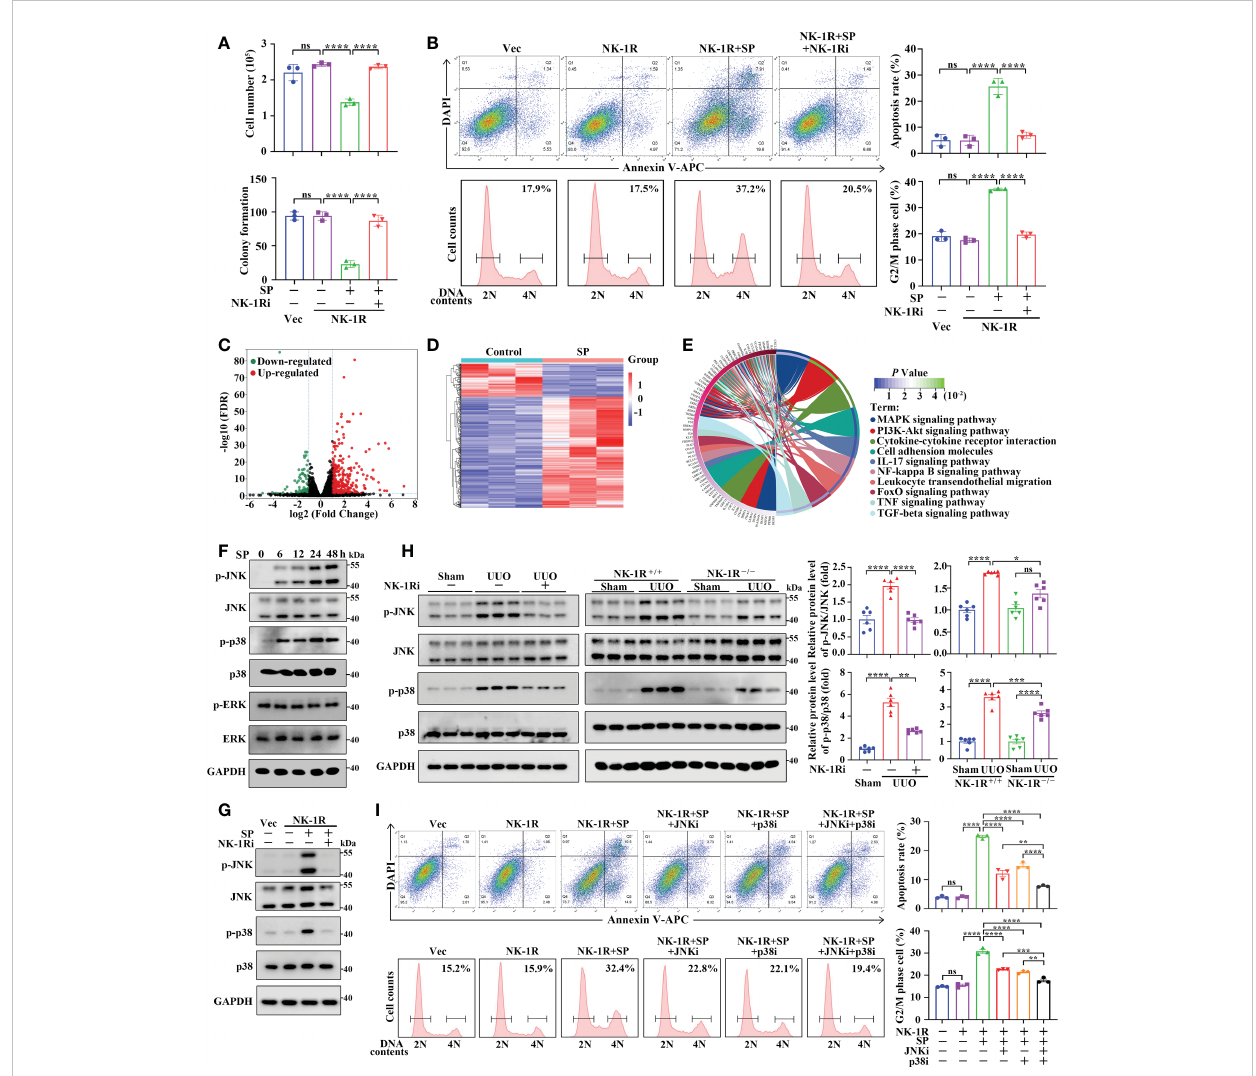
FIGURE 7 SP mediates renal in fl ammation and fi brosis through an NK-1R-dependent JNK/p38 mechanism in vivo and in vitro . (A, B) The NK-1R inhibitor abrogated the suppressive effect of SP on cell growth and colony formation (A) and abolished SP-induced apoptosis and G2/M arrest (B) in NK-1R- overexpressed HK-2 cells. For B, representative images (left panels) and quantitative data (right panels) are shown. (C, D) The volcano plot (C) and heatmap (D) of differentially expressed genes (DEGs) between NK-1R-overexpressed HK-2 cells treated with SP or its control using the criteria of FDR < 0.05 and |log2 (Fold Change)| > = 1. (E) The circos plot for the KEGG enrichment of indicated DEGs. (F, G) Western blotting showed a time- dependent increase in phosphorylated JNK and p38 but not ERK levels in NK-1R-overexpressed HK-2 cells upon SP incubation and that treatment with the NK-1R inhibitor blocked SP-induced increases in the expression of phosphorylated p38 and JNK. (H) Inhibition of NK-1R using both an NK-1R inhibitor and genetic knock-out strategies impaired the UUO-mediated elevation of phosphorylated JNK and p38 levels in mouse kidneys. (I) p38- or JNK-speci fi c inhibitors or their combination signi fi cantly attenuated SP-stimulated G2/M arrest and apoptosis. For H and I, representative images (left panels) and quantitative data (right panels) are shown. Data are presented as mean ± SEM. * p < 0.05; ** p < 0.01; *** p < 0.001; **** p < 0.0001; ns, not signi fi